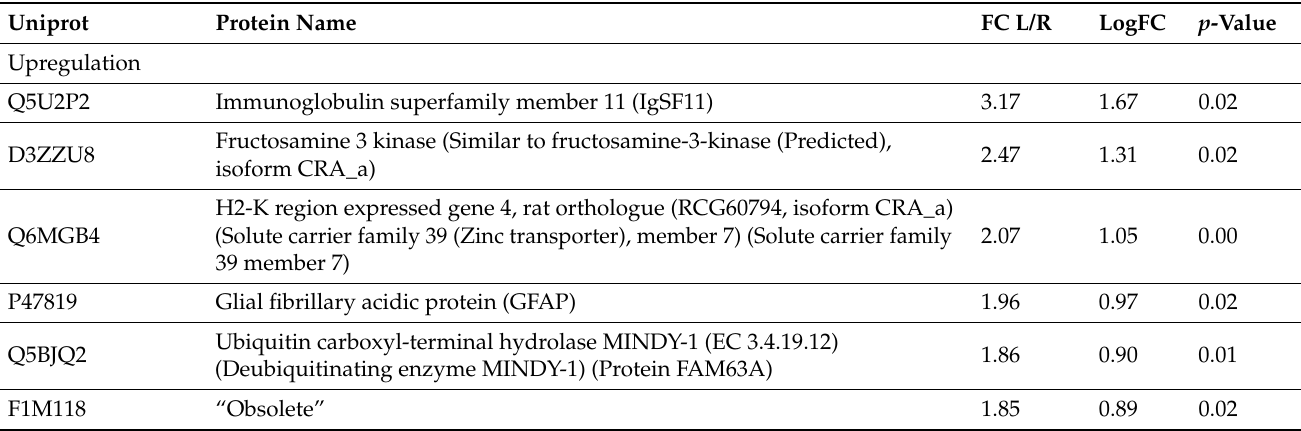
Table 3. Protein regulation in the nasal quadrant 2 weeks after pONT compared to contralateral control ( p < 0.05 and FC log2 > 0.43 (upregulation) or ≤− 0.43 (downregulation)). R = right; L = left; FC = fold